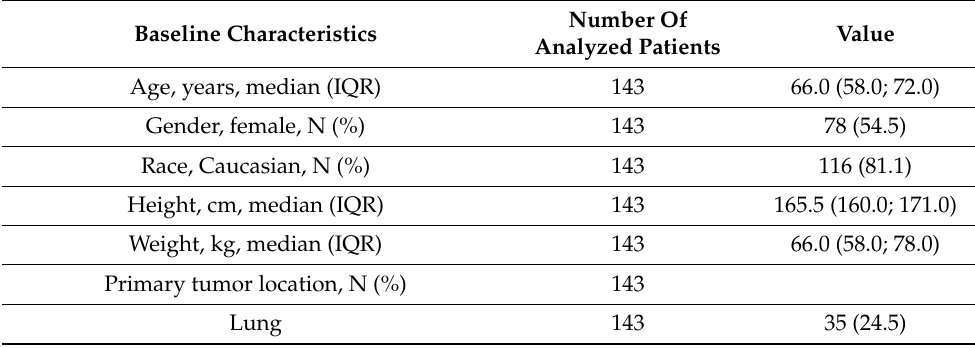
Table 1. Baseline clinical and demographic